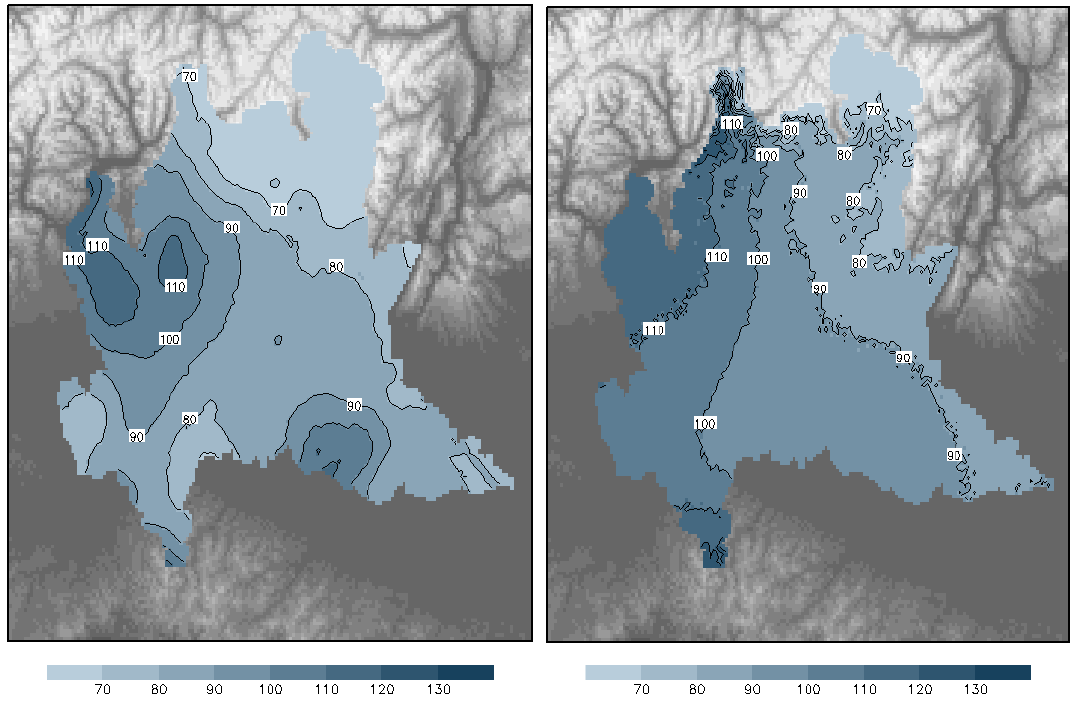
Fig. 7. Raindepth threshold h T (mm) for event duration D = 3 h and return period T = 200 yr. Left panel: estimate obtained with the previous operational scheme, based on station-point estimation at 69 sites and subsequent interpolation. Right panel: estimate obtained by applying the proposed method to the same 69 stations.